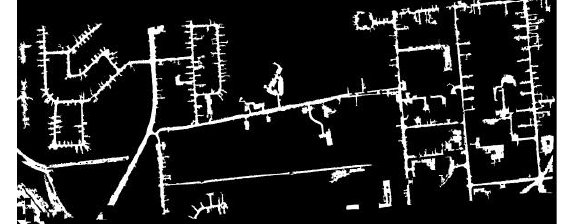
Figure 7. Resultant road network map